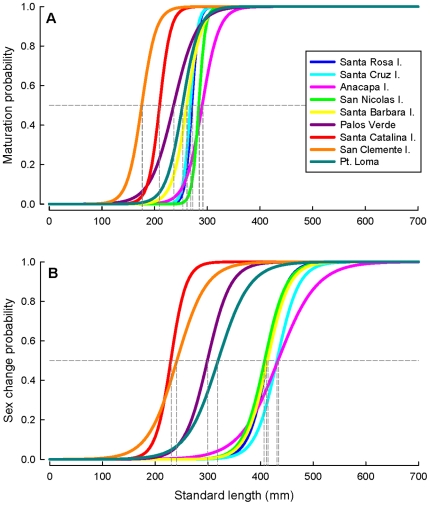
Logistic regression curves predicting (A) the size at maturation and (B) the size at sex change among the nine populations of California sheephead sampled in southern California.Vertical dashed grey lines represent the size of maturation and sex change, defined as the size at which 50% of the population (horizontal dashed line) is a mature female (i.e., maturation) or a mature male (i.e., sex change), respectively.